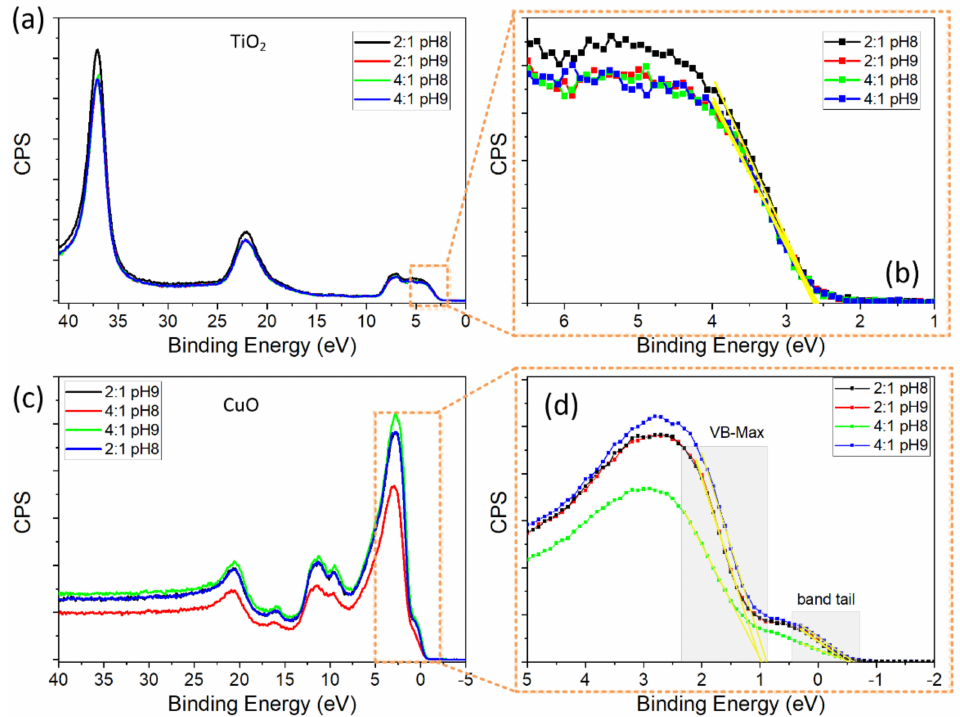
Figure 10. XPS spectra of ( a ) TiO 2 and ( c ) CuO powders taken around a low-binding energy region. ( b , d ) are the XPS valence band spectra of the oxides extracted from ( a , c ), respectively. From the E g and E VB values previously estimated, we calculate the conduction band energy ( E CB ) ( E CB = E VB − E g [63]) values that are listed in Table 1. Thus, we have the full information of the energy bands of our powders. According to Table 1, all TiO 2 powders have a similar E CB of around − 0.58 eV, a value that is lower than that found in most of the CuO powders (~ − 0.51 eV). Similar to E VB , the CuO powder synthesized by the 4:1 pH9 route presents a lower E CB ( − 0.62 eV). It is important to note that the values of E CB for the CuO powders are slightly higher than the minimum E VB and, as a consequence, show an overlapping effect between the valence and conduction bands. From the electrical point of view, this overlapping induces a metal behavior in some regions placed at the grain surface of the CuO system. This metallic behavior observed at the surface of the semiconductor oxide can be used to trap photogenerated electrons, preventing a rapid electron-hole recombination, a useful mechanism to improve the photocatalytic activity of this system [64]. In Figure 11, we present a diagram of the energy bands for the TiO 2 and CuO powders synthesized by the 2:1 pH8 route, which represent the general behavior of the studied